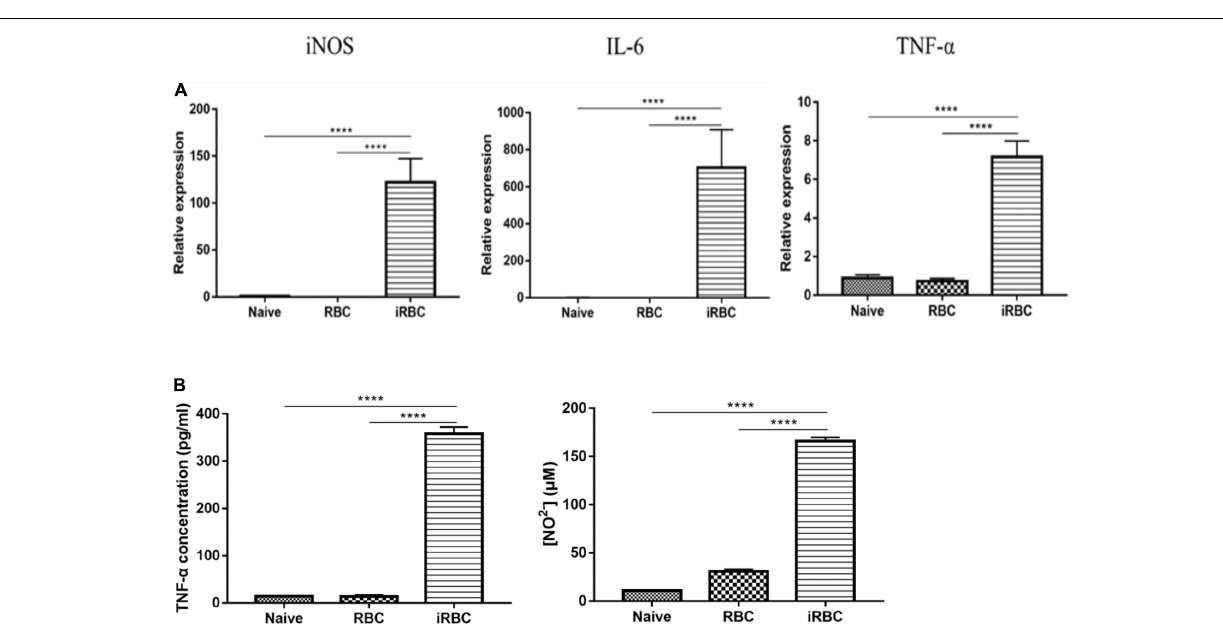
Frontiers in Microbiology |